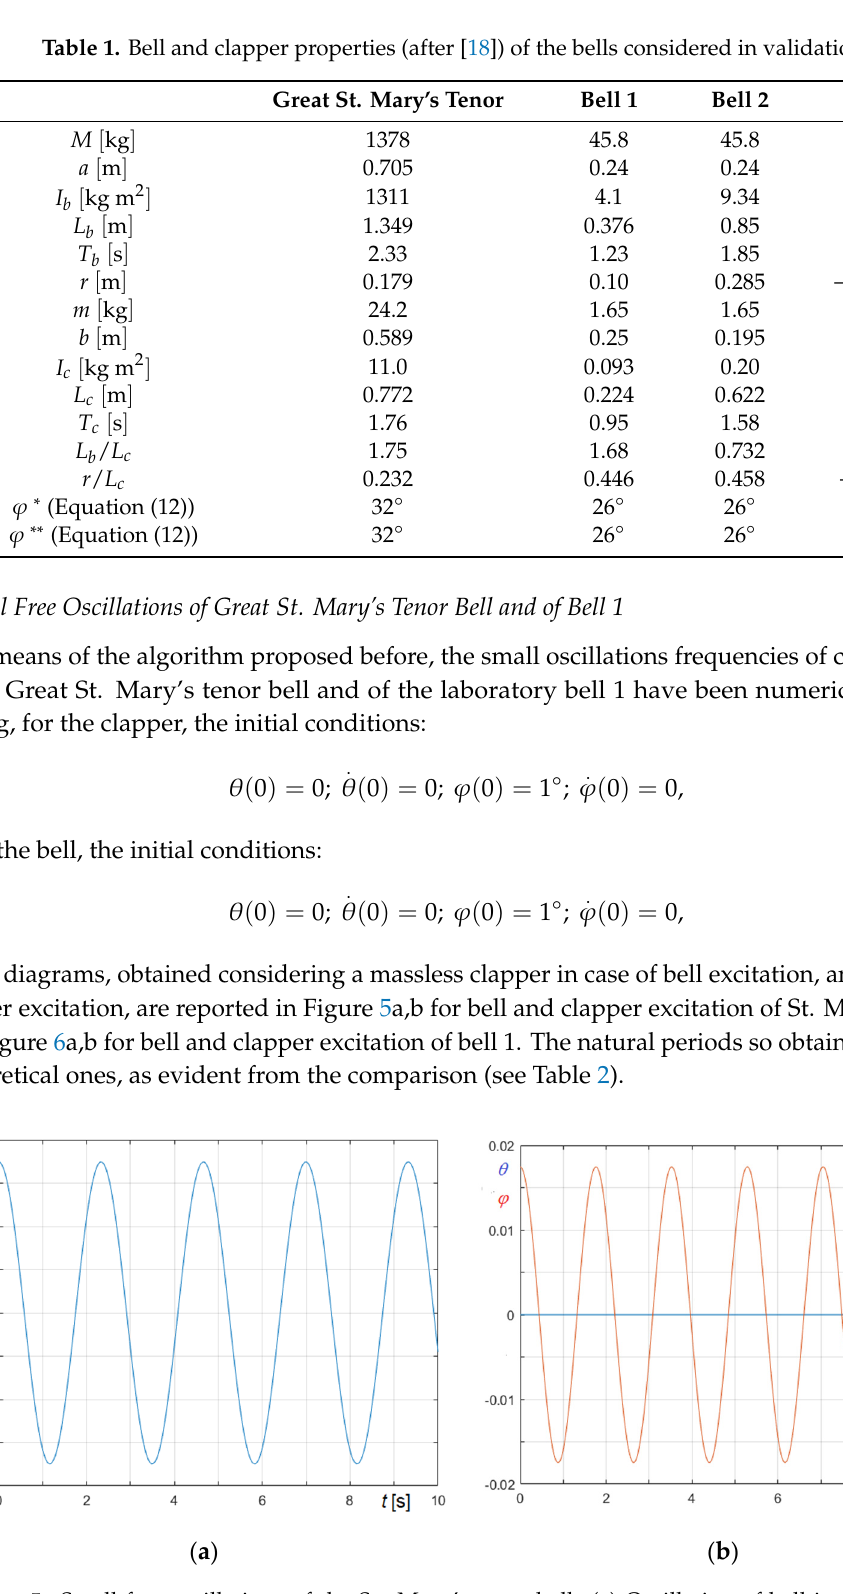
( a ) ( b ) Figure 6. Small free oscillations of the bell 1: ( a ) Oscillation of bell in case of bell excitation; ( b ) Oscillation of bell and clapper in case of clapper excitation. 7.2. Bell Oscillations and Clapper Strikes of Three Reference Bells As recalled before, the clapper strikes on one cycle of a free oscillating bell have been extensively studied in [18], where results are diagrammatically shown for the three reference bells. Assuming the properties already recalled in Table 1, the cycles, starting at an angle of 171°, have been reproduced with the proposed algorithm, considering two cases, according as the bell is starting ringing right or wrong. The bell is said to be ringing right if the clapper impacts are “in phase” with the bell oscillations, i.e., the clapper impacts the bell on the upper part of the mouth, or it is said ringing wrong if the clapper impacts are “in opposition of phase” with the bell oscillations, i.e., the clapper impacts the bell on the lower part of the mouth. Analytically, the bell starts ringing right if the first clapper impact satisfies the condition: sgn (cid:4666)(cid:2016) (cid:2030)(cid:3364)(cid:4667) = 1,